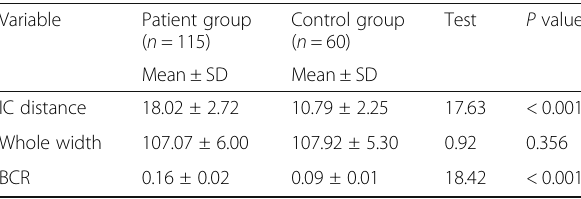
Table 2 The mean BCR (+ SD) among the patients and control subjects (IC = inter-caudate) Variable